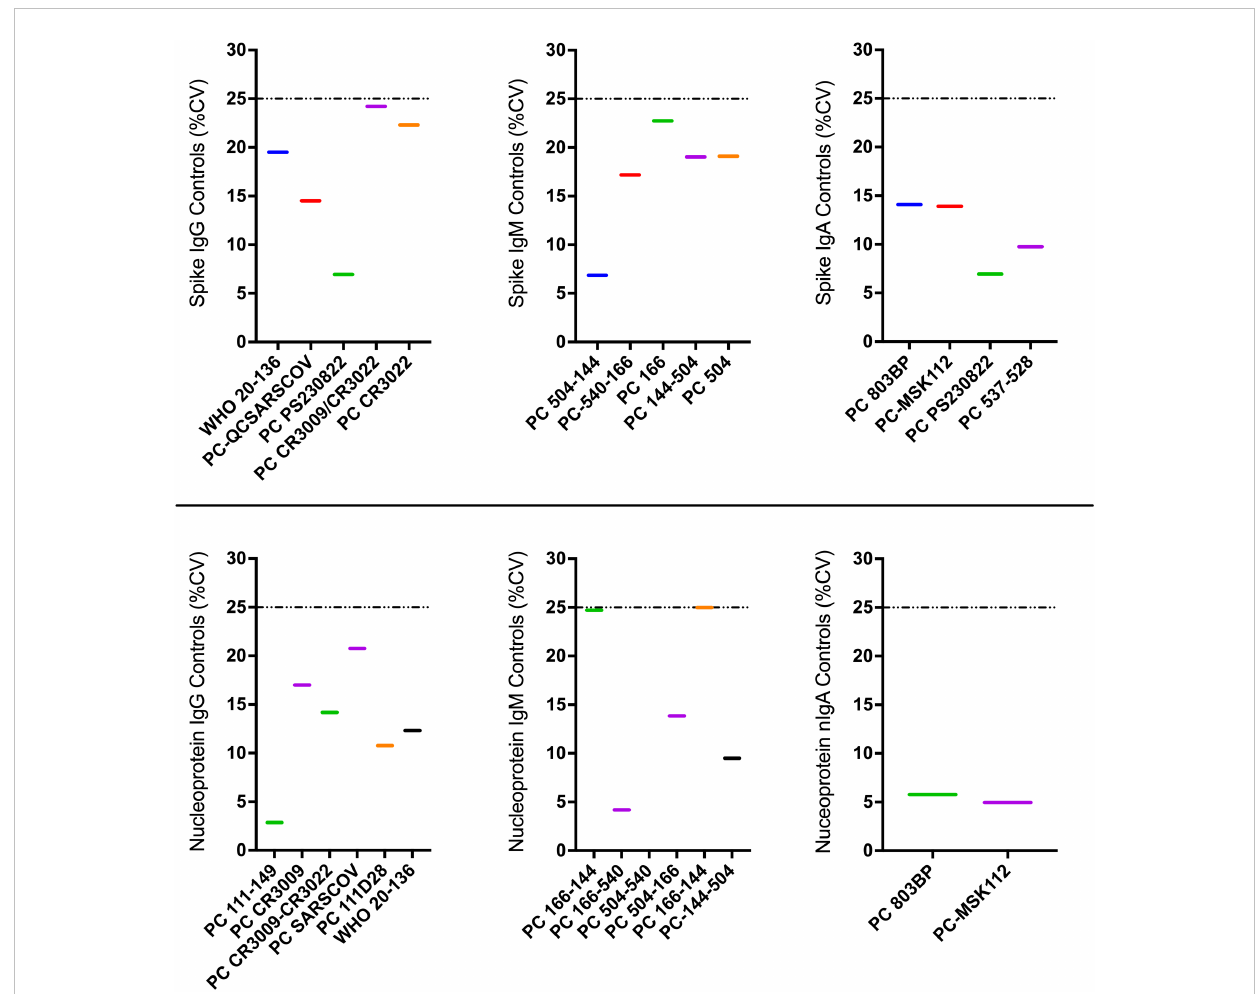
FIGURE 5 Illustrates inter-operator pro fi ciency comparisons obtained by different operators testing identical control specimens repeatedly as part of the in- house ELISA. Colored horizontal bars represent the %CVs of concentrations for each quanti fi ed antibody-antigen speci fi city. The dotted horizontal lines represent the 25% CV pro fi ciency